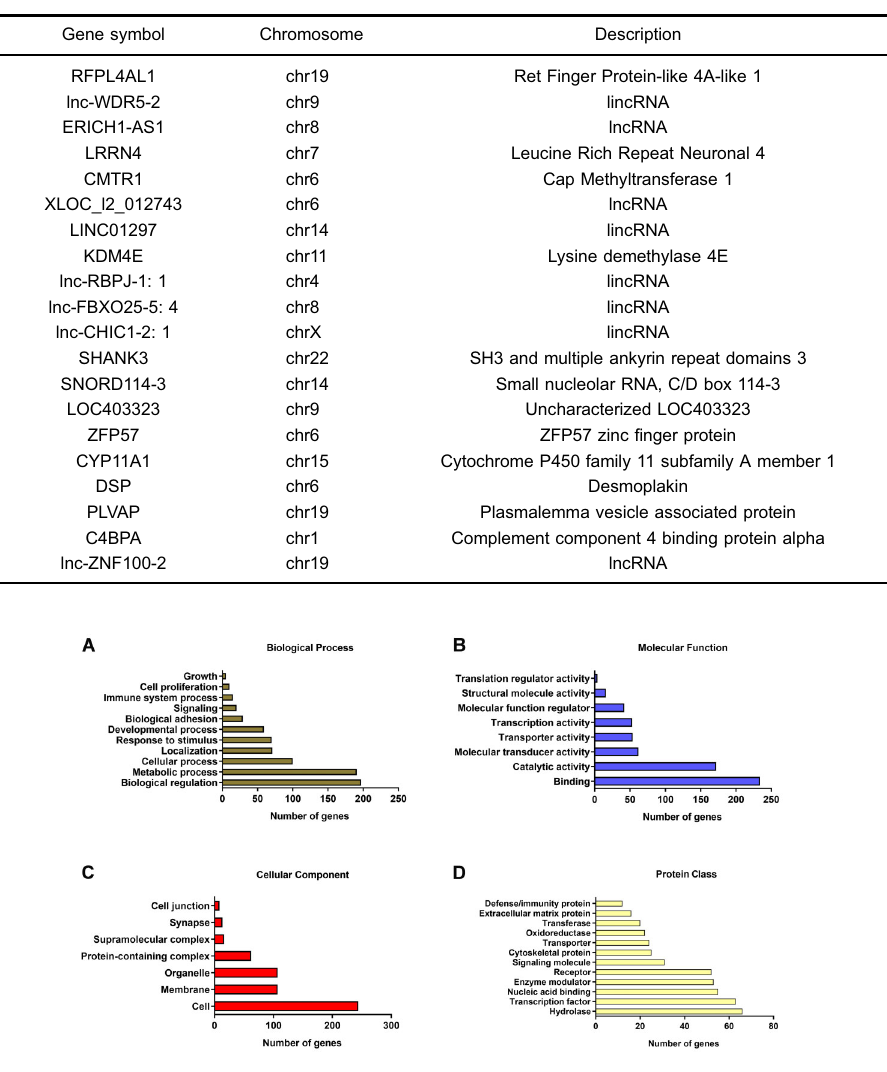
Braz J Med Biol Res | doi: